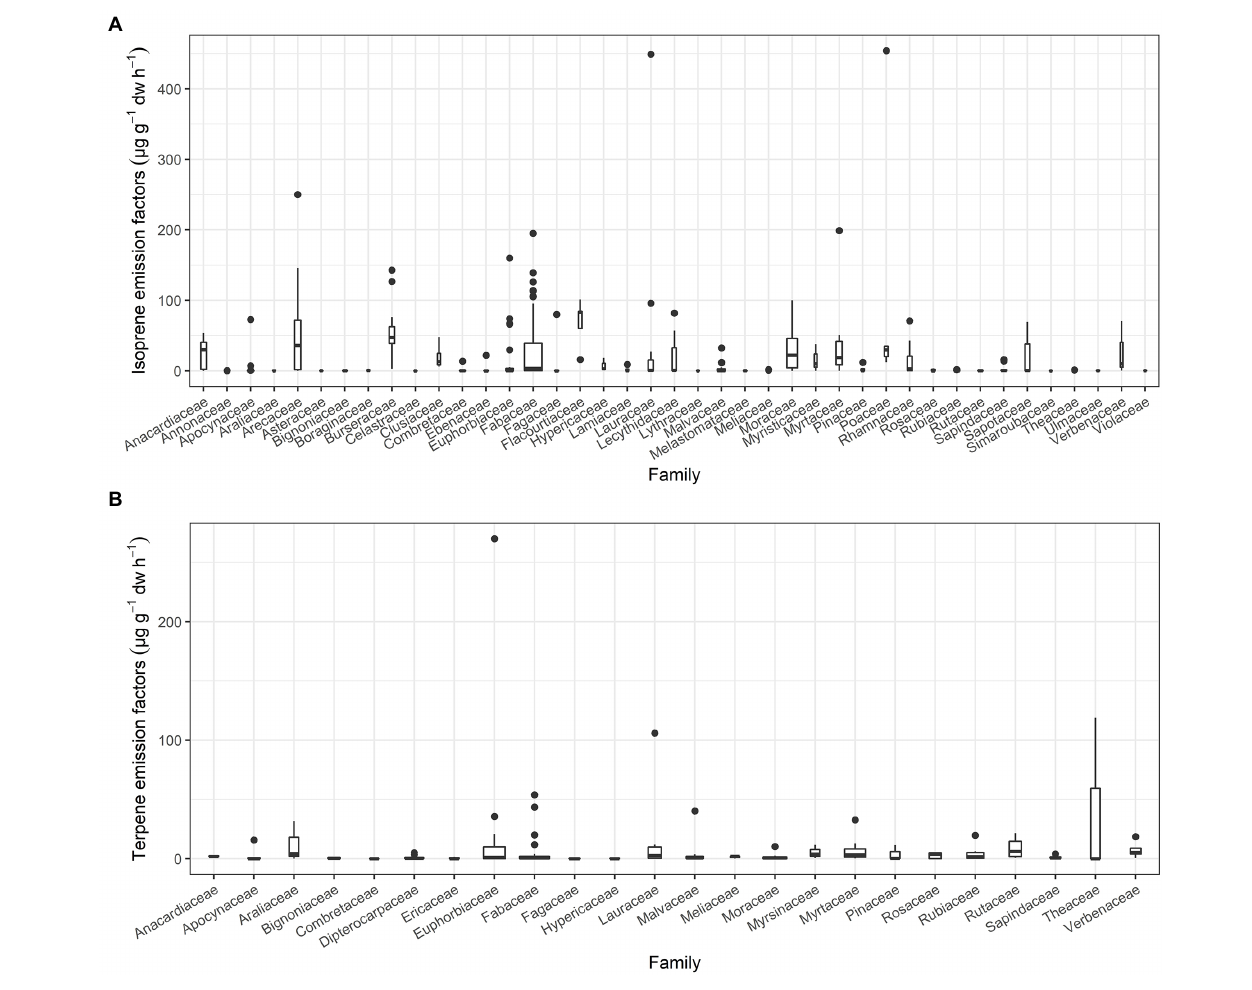
FIGURE 2 | Factors of isoprene (A) and terpene (B) emissions with more than three species for tropical plant families ( Appendix S1 ). The box is drawn from the first quartile (Q1) with a whisker to the minimum to the third quartile (Q3) with a whisker to the maximum. The median is represented by the line in the box, and outliers are identified by dots. The width of box is proportional to the number of tropical species